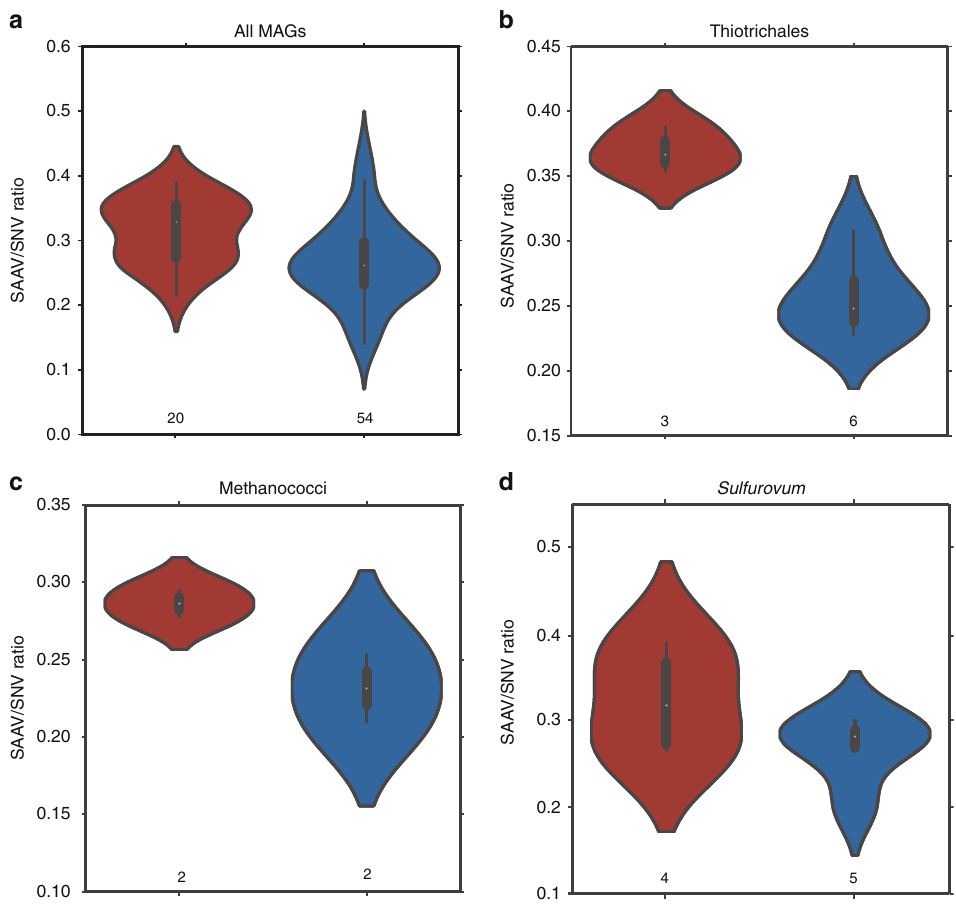
Fig. 2 Violin plots showing a kernel density estimation of the underlying distribution of the SAAV to SNV ratio for all MAGs from the Piccard (red) and Von Damm (blue) vent fi elds. The boxes inside each plot denote the upper and lower quartiles within the distribution, the white dot represents the average. Numbers below each violin indicate the number of MAGs included in that sample. a All MAGs from Piccard and Von Damm; b Thiotrichales MAGs only; c Methanococci MAGs only; d Sulfurovum MAGs only. Differences in the distribution of the logs of the SAAV/SNV ratio between MAGs from Piccard and Von Damm were signi fi cant for all MAGs ( t -test, p : 0.0005) and for Thiotrichales ( t -test, p : 0.0002)